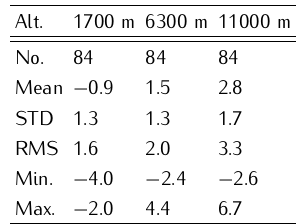
Table 6. Statistics of the residual gravity anomalies with ground truth. Units in mGal.